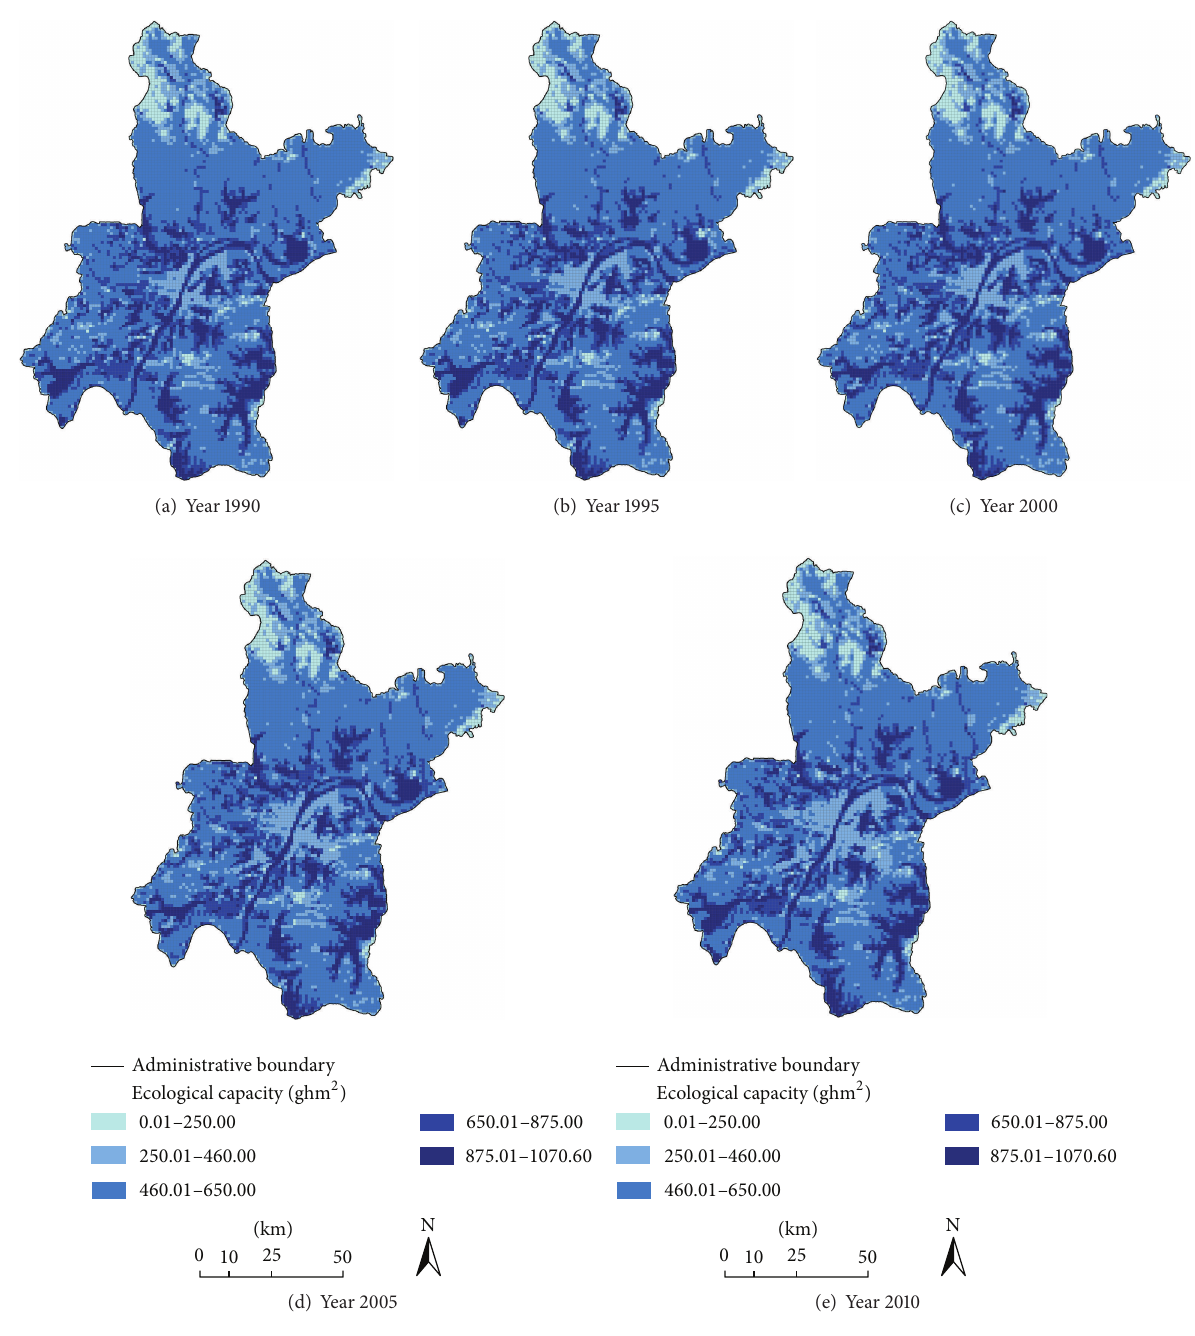
Figure 4: Spatial distribution of total ecological capacity of Wuhan city during 1990–2010.